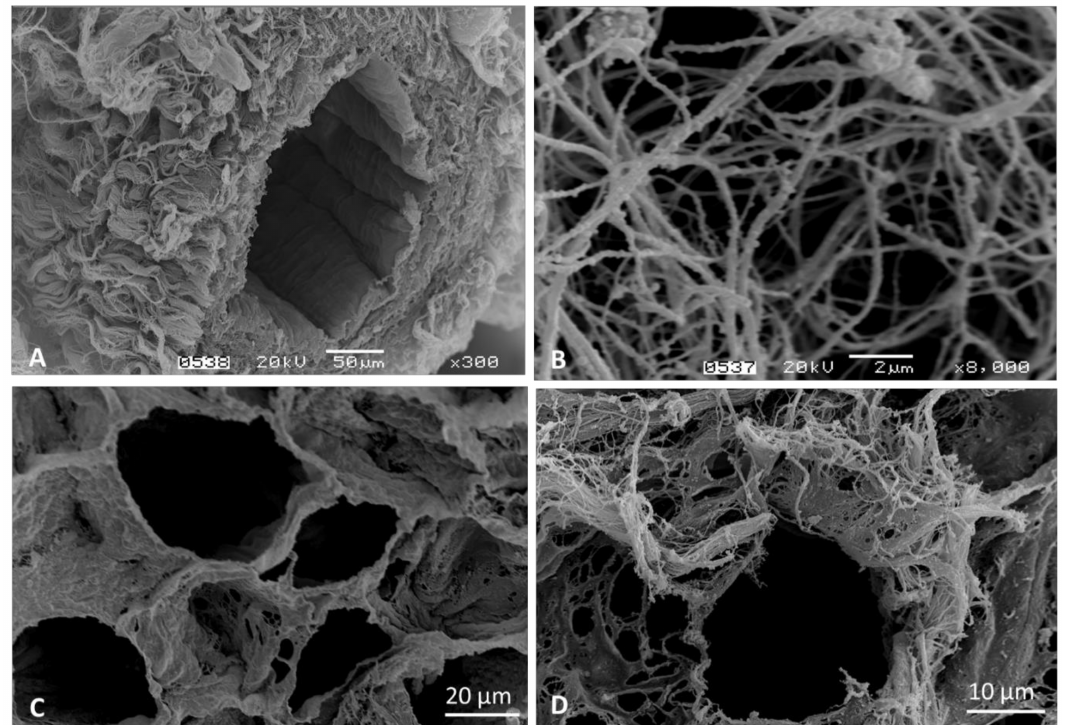
Figure 3. Scanning electron microscopy imaging of the bovine decellularized bone marrow. ( A ) Intact vascular structure, ( B ) Reticular fibers in connective tissue, ( C ) Adipose tissue ECM, preserved cellular niches, ( D ) Individual cell niche. The images are part of the Hematology and Hemotherapy Center archive of the characterization of the decellularized bone marrow (DeBM) [18]; however, these images have not been published elsewhere.